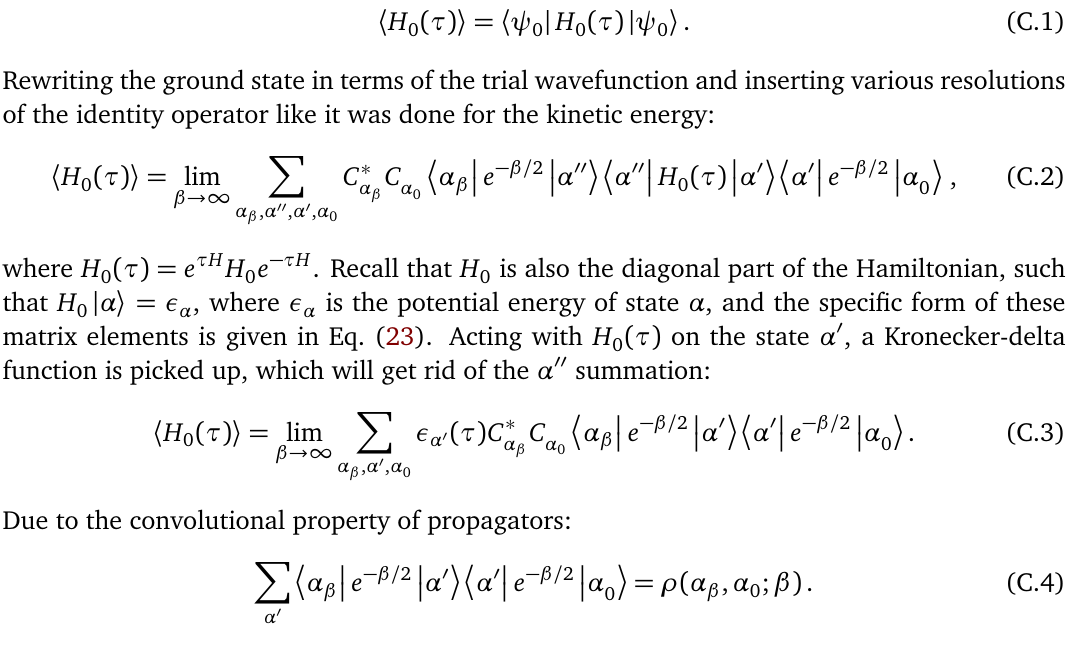
Figure 20: Insert / Delete kink after tail. A kink is inserted between neighboring sites i , j after the worm tail at a randomly sampled time τ moved to the site where the particle hops from. The upper bound of the sampling interval τ is chosen to be the smallest out of the two upper bounds of the corre- max sponding flat intervals. This ensures that the new kink does not interfere with other kinks, which simplifies the implementation. The complementary update is to delete the kink and move the tail back to the site from where the particle is hopping